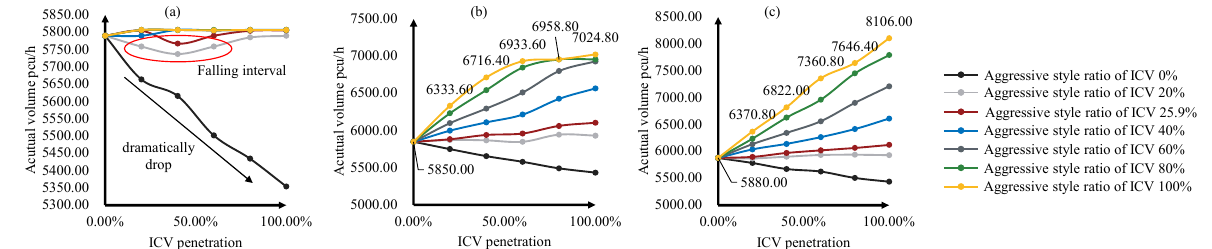
Figure 6. The impacts of SLADS on road capacity of the expressway under different driving styles with the volume input being equal to the saturated service level ( a ), 20% oversaturated service level ( b ) and 40% oversaturated service level ( c ).